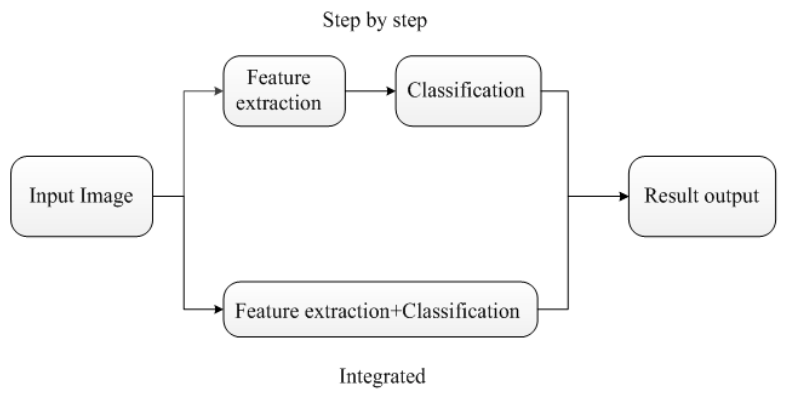
Figure 13. Two models of image processing.